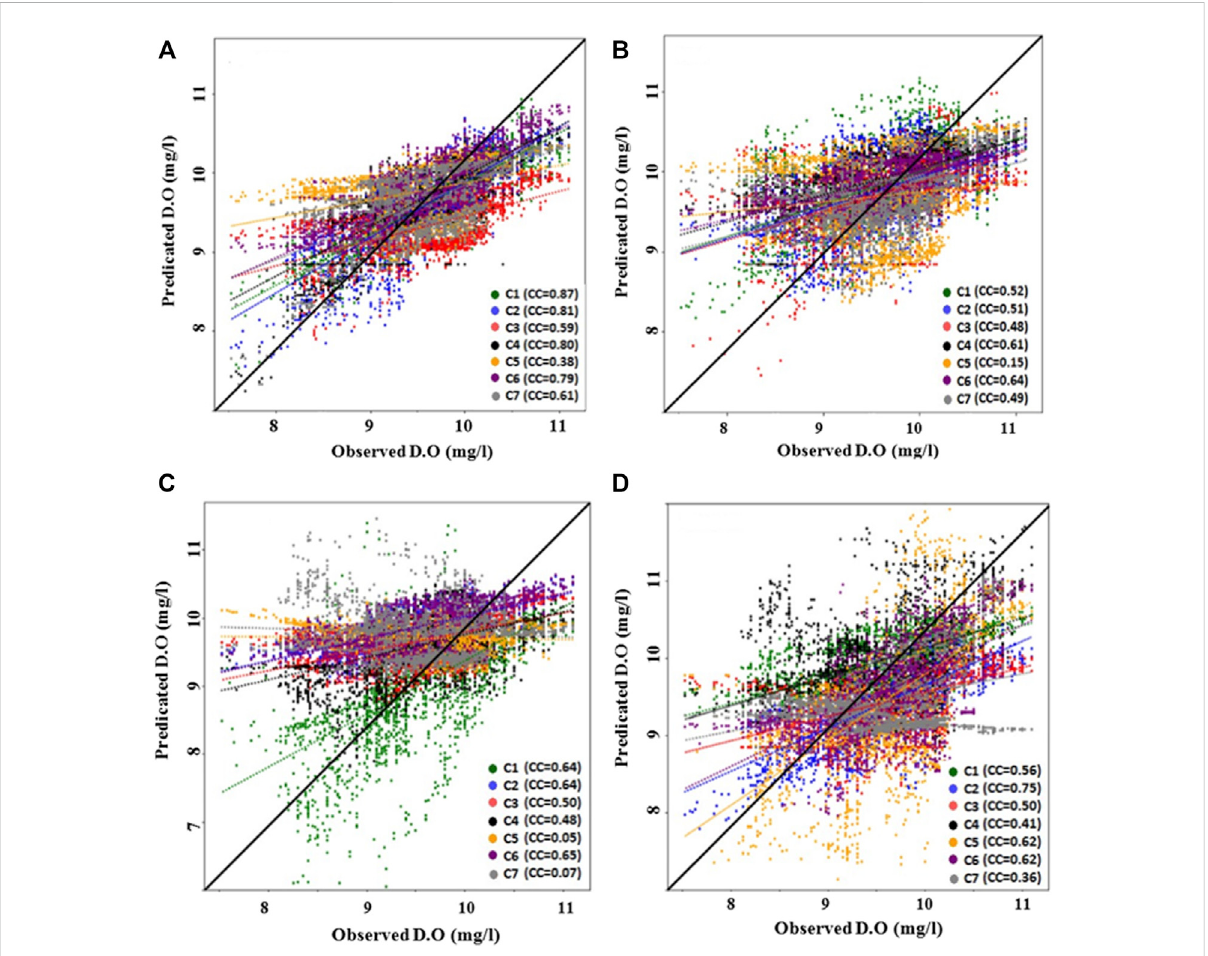
FIGURE 7 Scatterplotofobservedandpredicteddissolvedoxygenby (A) NF-GWO; (B) NF; (C) NF-SC;and (D) NF-FCMmodelsduringthetestingphaseat